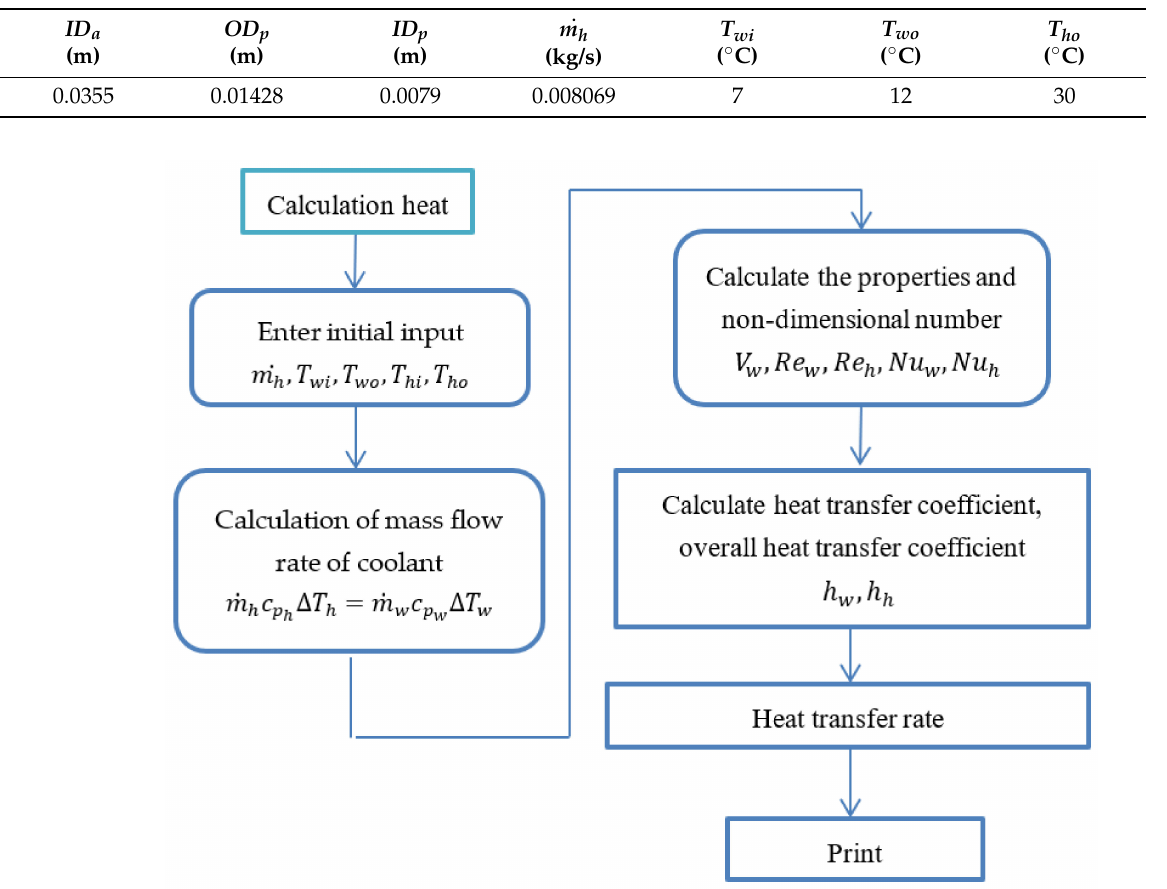
Figure 9. Analysis algorithm for the heat